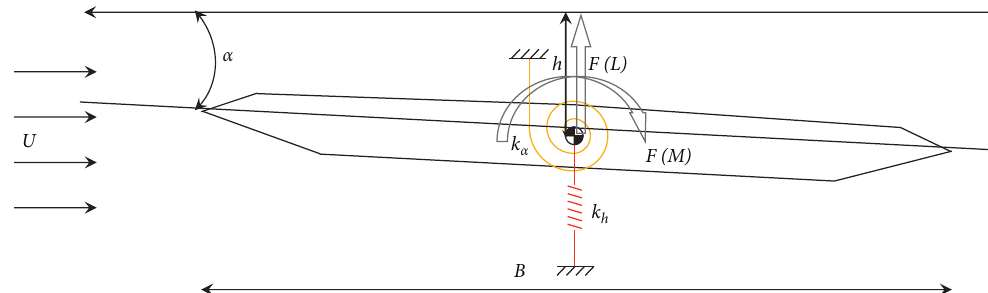
Figure 2: Two-degree bridge deck